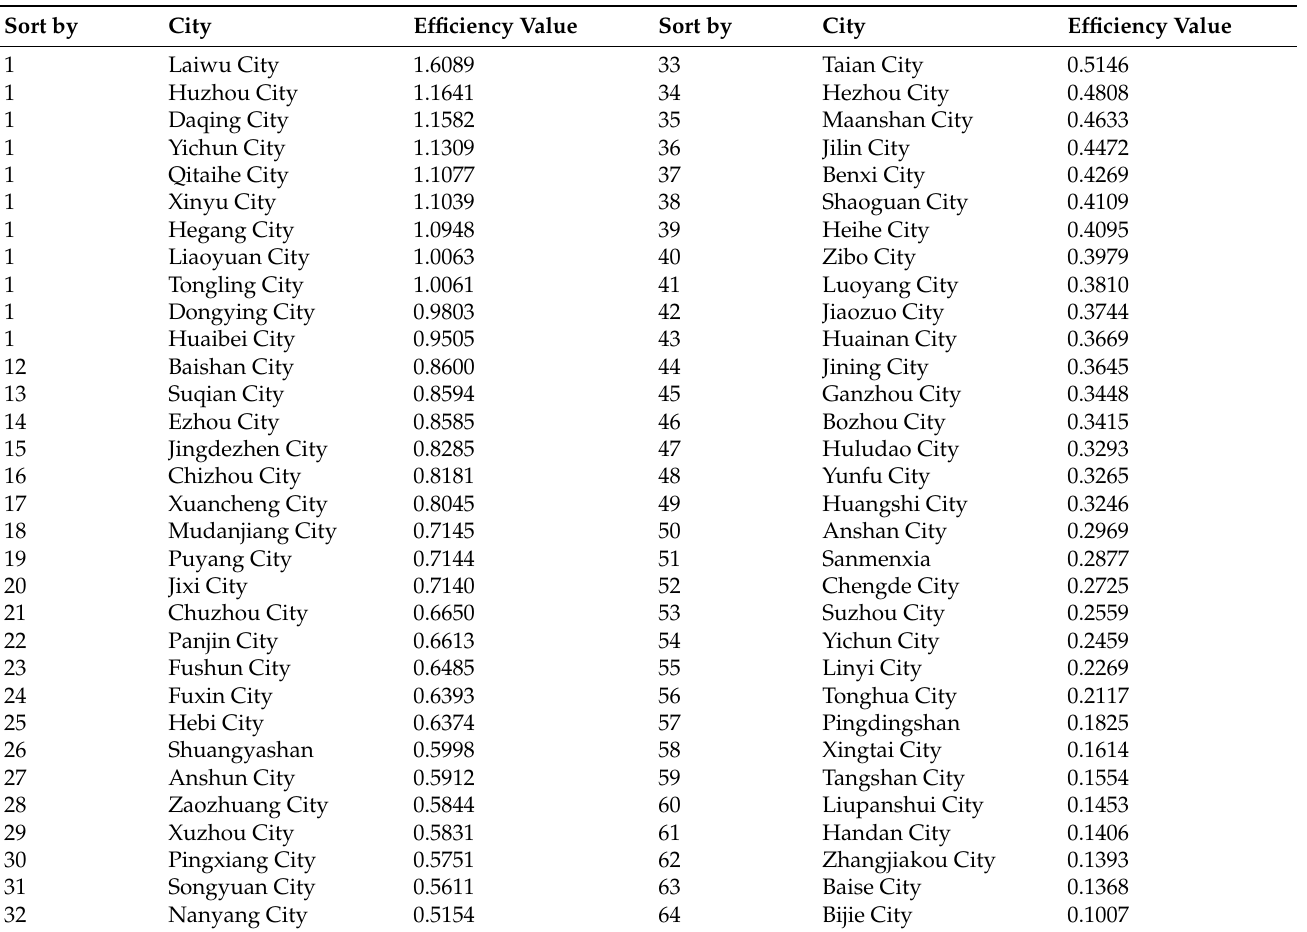
Table 3. Mean value of green innovation efficiency in resource-based